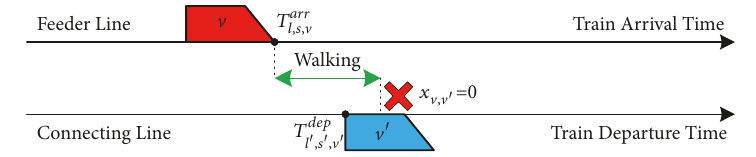
Figure 2: The failed transfer